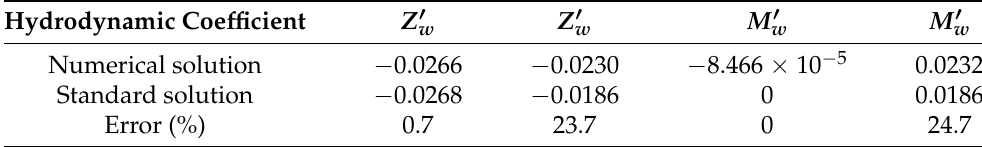
Table 5. Comparison of results of our method with the experiment in [39].